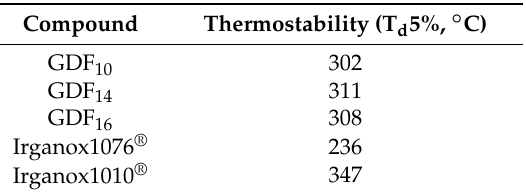
Table 2. Thermostability (T d 5%) of GDF x